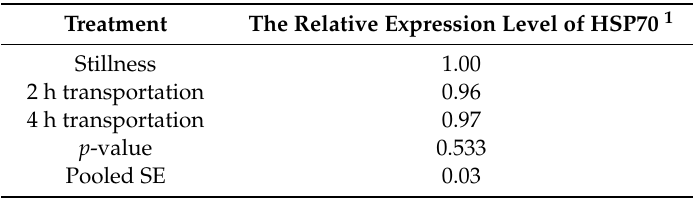
Table 6. E ff ect of di ff erent transportation treatments on the relative mRNA expression of HSP70 in broiler